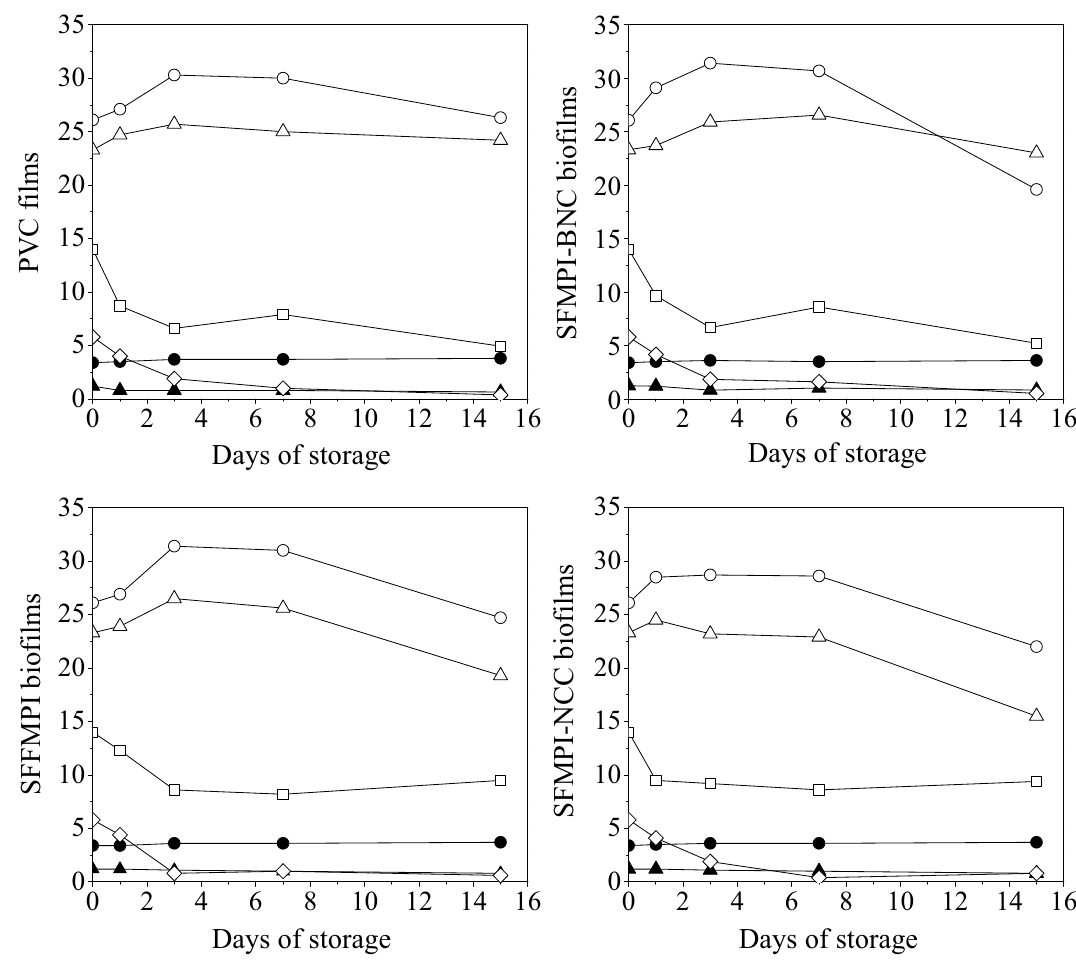
Figure 4. Time course of pH ( ● ), TTA ( ▲ ), glucose (∆), fructose ( ○ ), sucrose (◊) and citric acid ( □ ) during storage of strawberries in containers sealed with conventional PVC, SFMPI, SFMPI-NCC and SFMPI-BNC- based biofilms over 15 days at 10